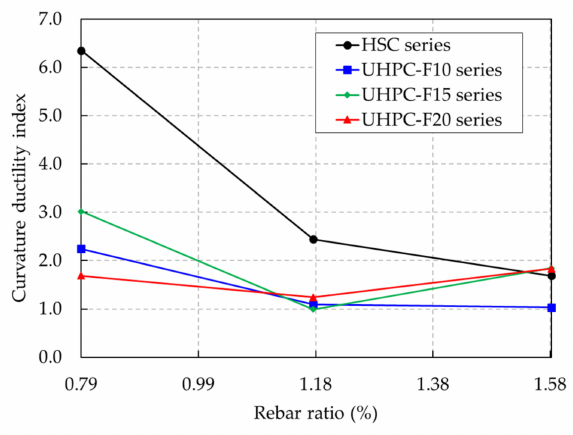
Figure 19. Curvature ductility indices of the UHPC and HSC beams with various rebar